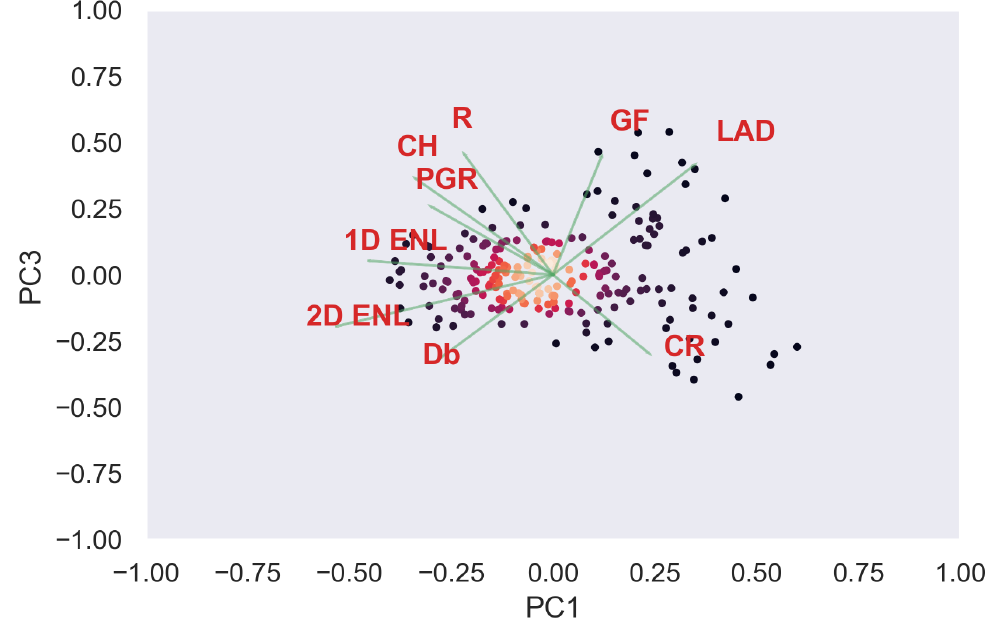
Figure A55. TLS PCA band 1 and 3 loadings at 5m grid